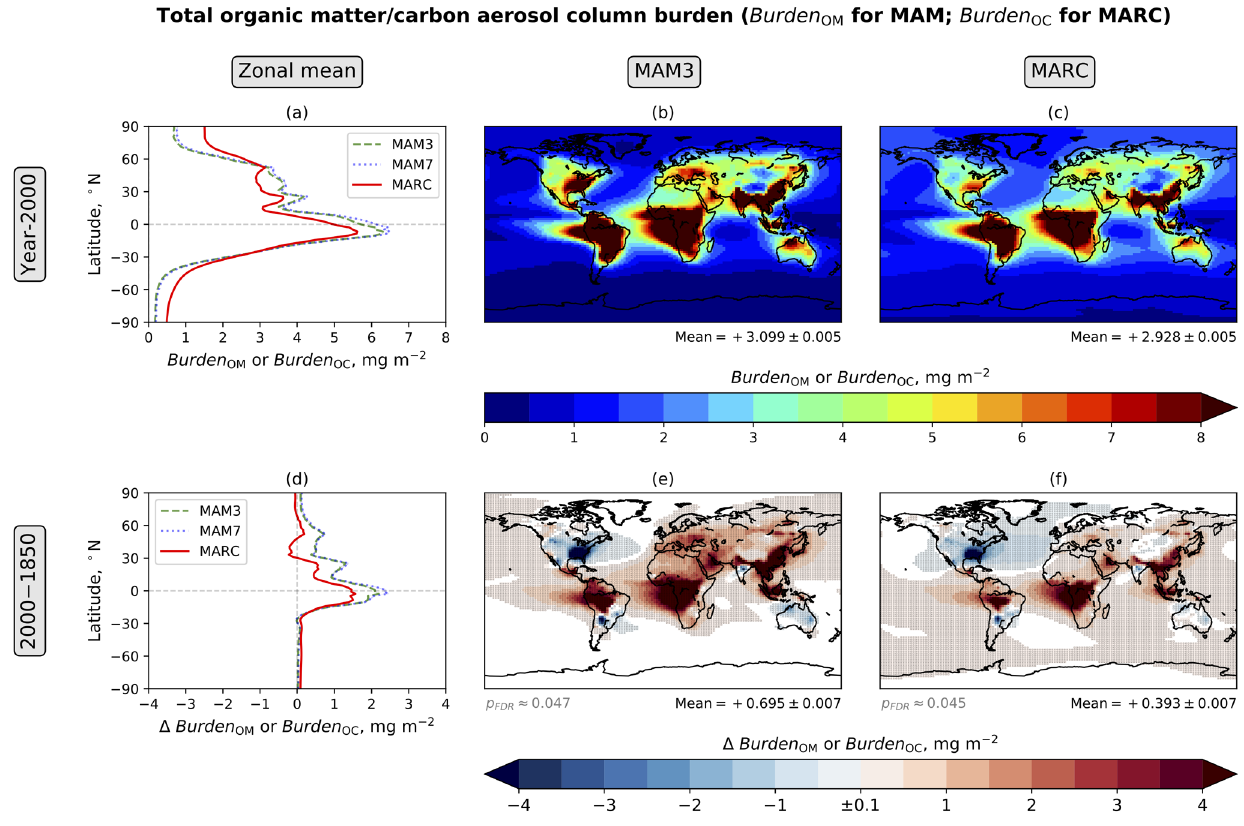
Figure 3. Annual mean total organic matter aerosol burden (Burden OM ) for MAM and total organic carbon aerosol burden (Burden OC ) for MARC. Due to different handling of organic carbon, MAM’s Burden OM is not directly equivalent to MARC’s Burden OC . Secondary organic aerosol from volatile organic compounds contributes to both Burden OM and Burden OC . The figure components are explained in the Fig. 2